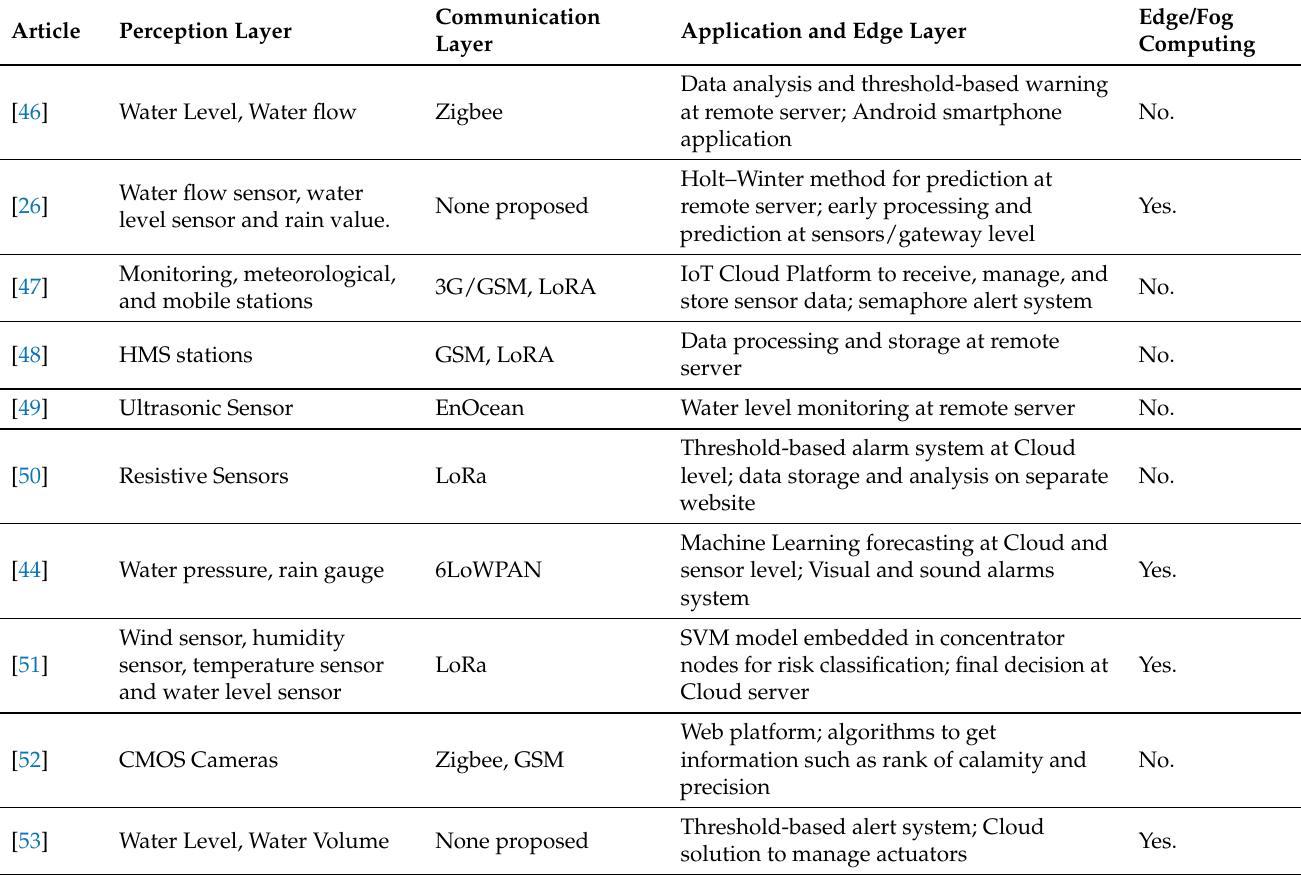
Table 2. Technologies and solutions used for each layer of the reviewed papers for Flood